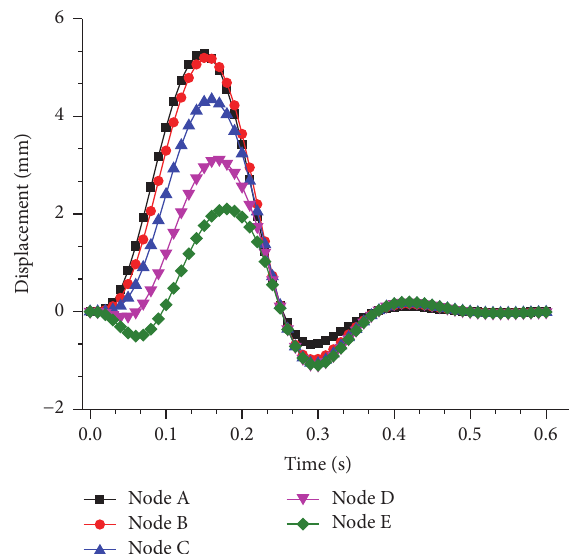
Figure 10: Slope time-history analysis horizontal displacement